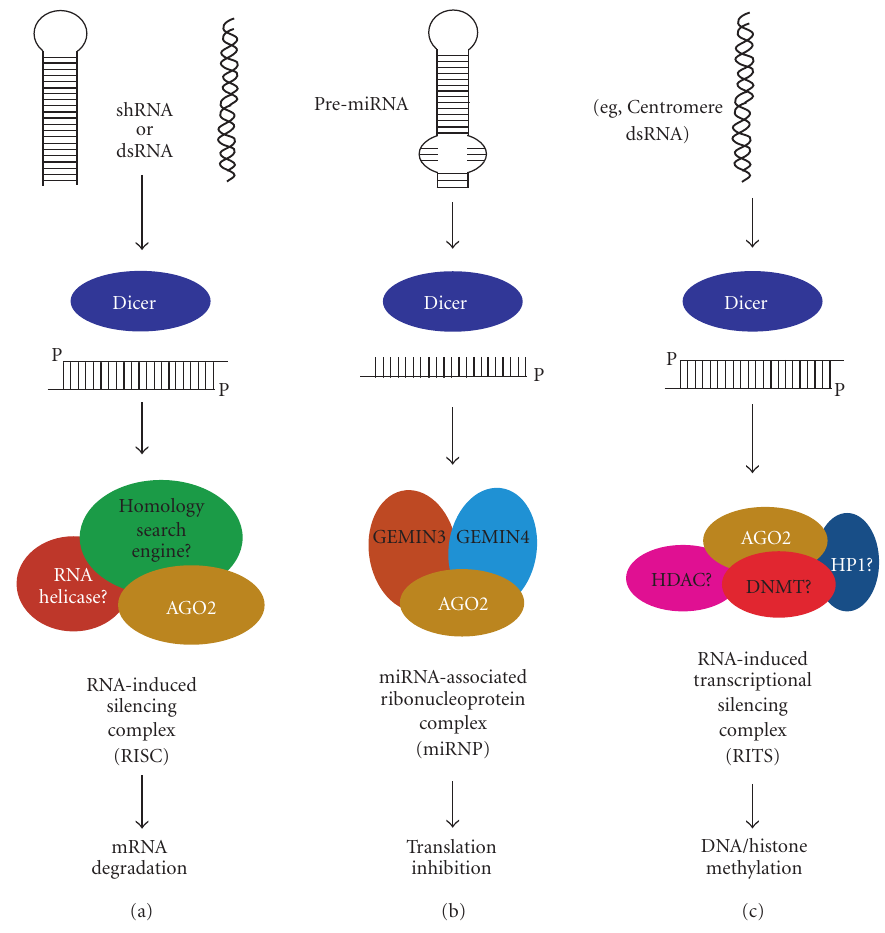
Figure 1: RNAi-based gene silencing pathways in H sapiens. (a) Dicer cleaves long double-stranded RNA (dsRNA) or short-hairpin RNA (shRNA) into functional siRNA with characteristic 3 (cid:2) overhangs. siRNAs are incorporated into RISC, recognize the target mRNA through an unknown subunit(s), and cleavage is performed by AGO2. (b) Precursor microRNAs (pre-miRNA), which themselves are a cleavage product of a primary microRNA transcript, are further processed by Dicer into functional miRNAs that associate with AGO2 into a miRNA ribonucleoprotein (miRNP). miRNPs recognize their target mRNAs resulting in translation inhibition by an undefined mechanism. (c) Transcriptional gene silencing is initiated by Dicer-mediated cleavage of long dsRNA (eg, centromere dsRNA) into siRNA that associate with the RITS complex. Putative components of H sapiens RITS are depicted: AGO-argonaute; DNMT-DNA methyltransferase; HDAC-histone deacetylase; HP1-heterochromatin protein